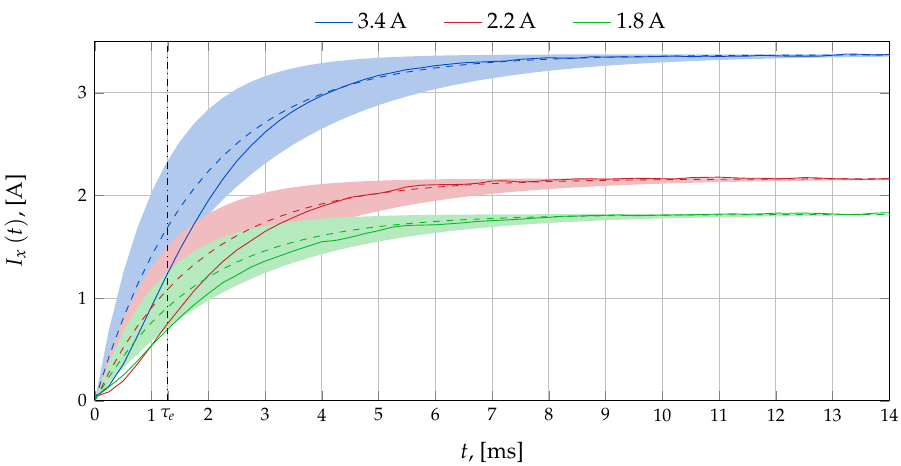
Figure 4. The BLDC blocked-rotor step responses are shown with continuous lines, along with the first-order model approximation with dashed lines. The uncertainty intervals are the shaded areas for each